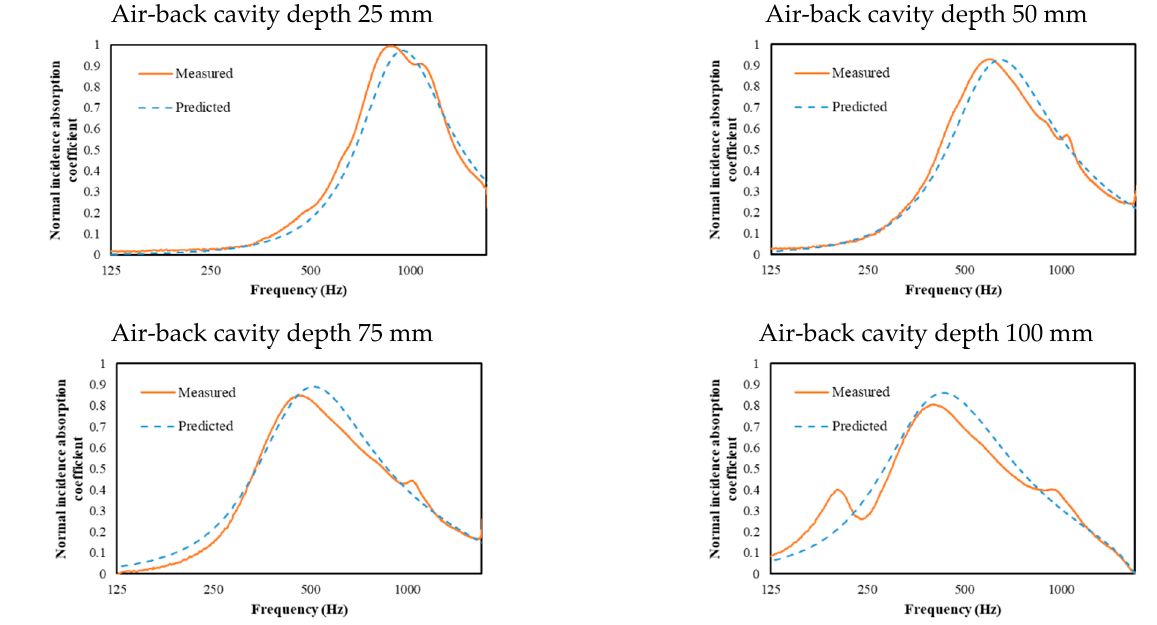
Figure 10. Comparison of the measured and predicted values of the normal incidence sound absorption coefficient of test specimen A. The orange solid line represents the measured values, and the blue dotted line represents the predicted values. Table 6. Mean absolute values of the error indices (Equations (4)–(6)) for the four air-back cavity depth conditions for specimens A–I.